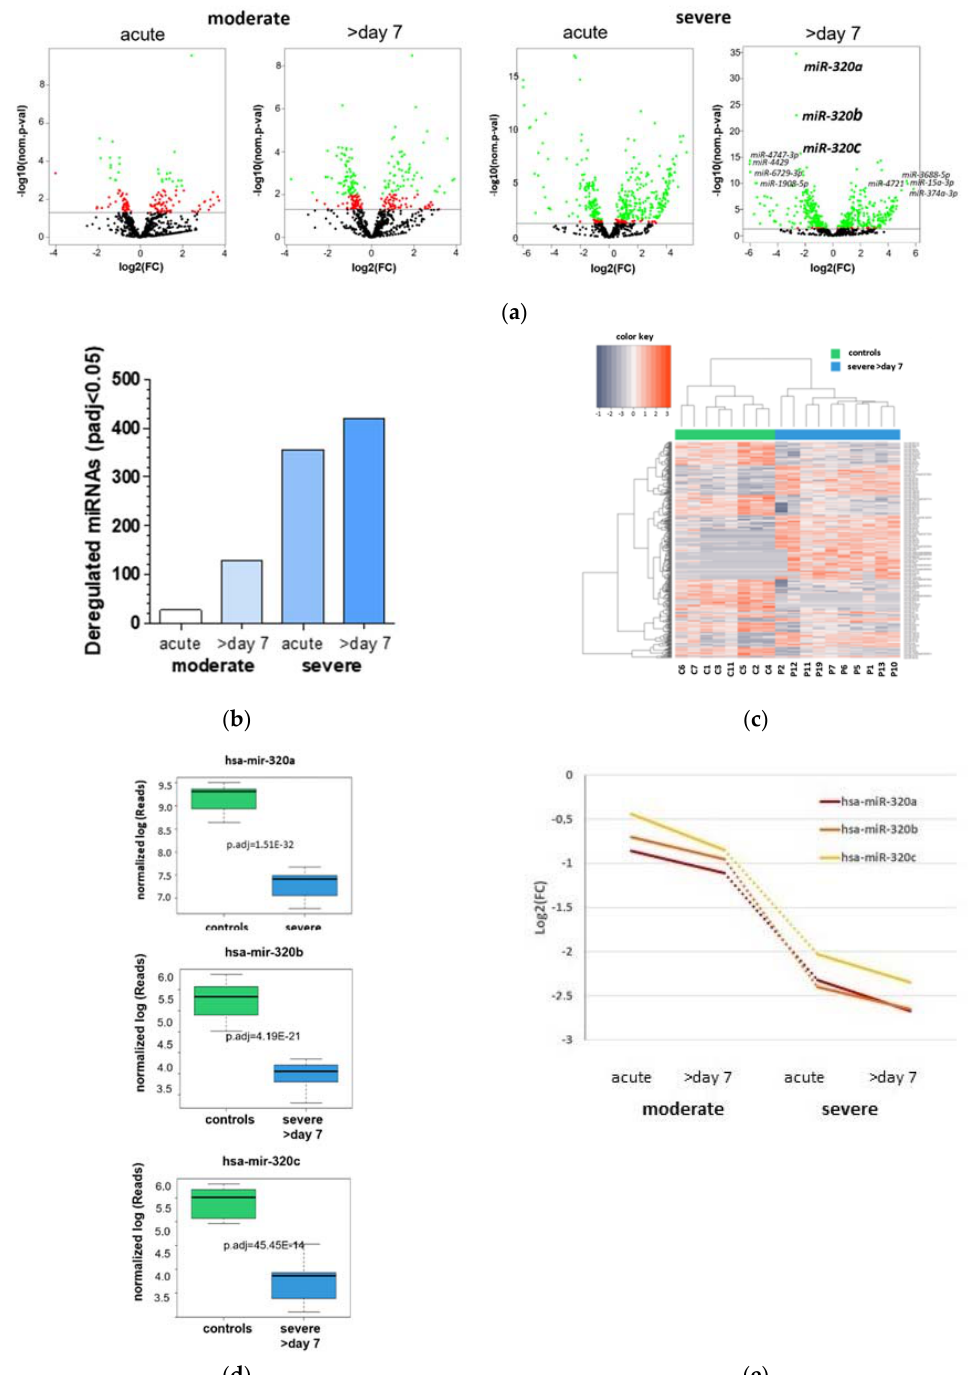
Figure 2. MicroRNA (MiRNA) expression in COVID-19 patients with moderate and severe respiratory failure. ( a ) Volcano plots and ( b ) graph showing number of dysregulated miRNAs ( p .adj < 0.05) in the peripheral blood of patients with moderate ( n = 11) and severe ( n = 10) respiratory failure induced by COVID-19 infection at the acute stage and 7 days later. ( c ) Color blot showing different miRNA expression and ( d ) graphs showing differences in miR-320a, miR-320b and miR-320c expression between patients with severe respiratory failure induced by COVID-19 infection and healthy controls ( n = 8). ( e ) Fold change expression of miR-320a, miR-320b and miR-320c of patients with moderate and severe respiratory failure induced by COVID-19 infections at acute stage and 7 days